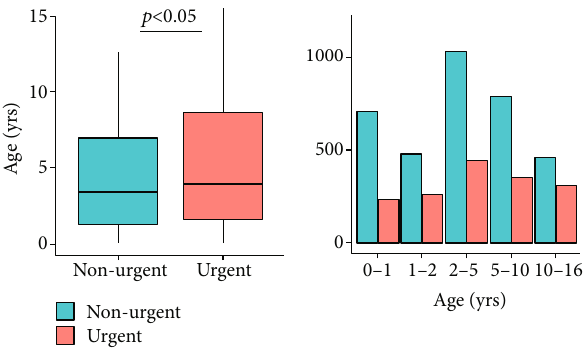
Figure 3: Age distribution in urgent and nonurgent visits in 2017.